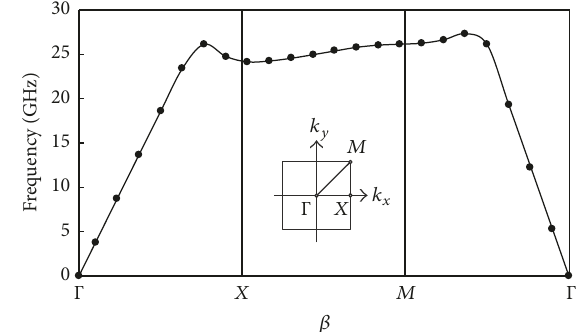
Figure 7: The dispersion diagram of the double-fractal based unit cells.